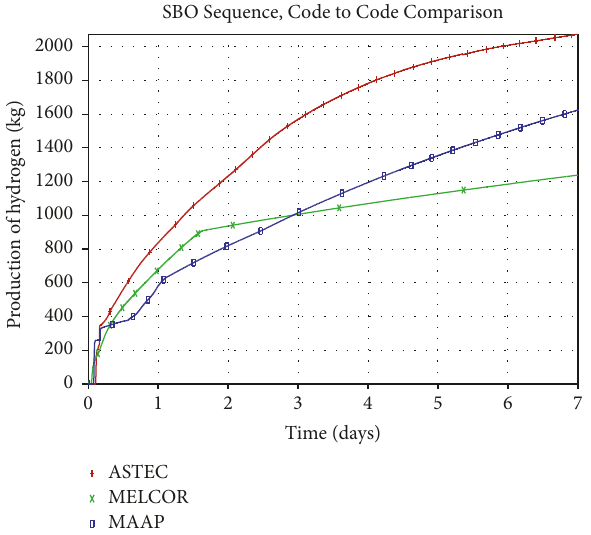
Figure 17: Total hydrogen production.